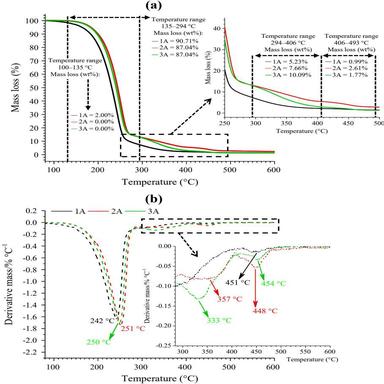
TG curves of the FEM samples (a) and their DTG (b) highlight regions associated to the fatty acid esters and contaminants.